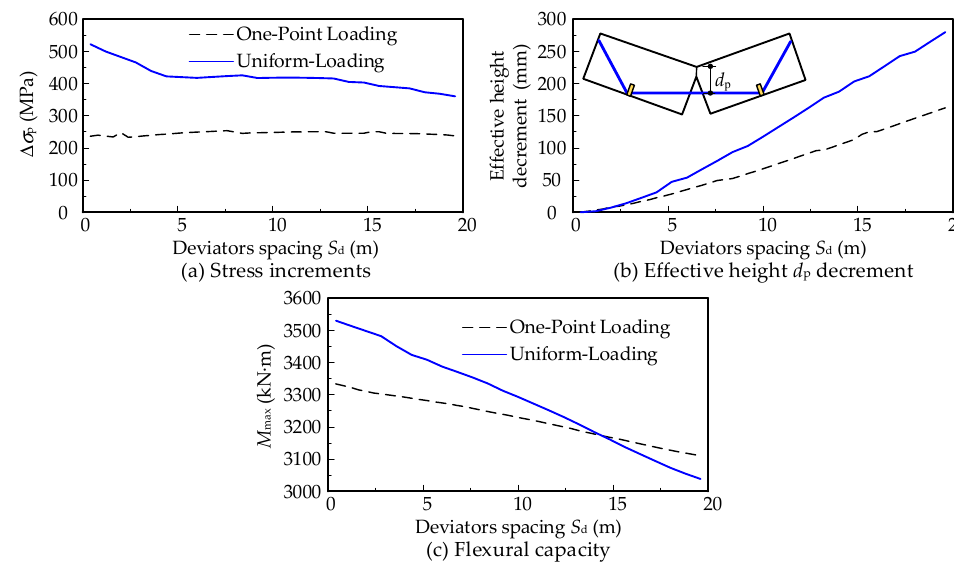
Figure 18. Effects of deviator spacing on flexural responses of EPCB.